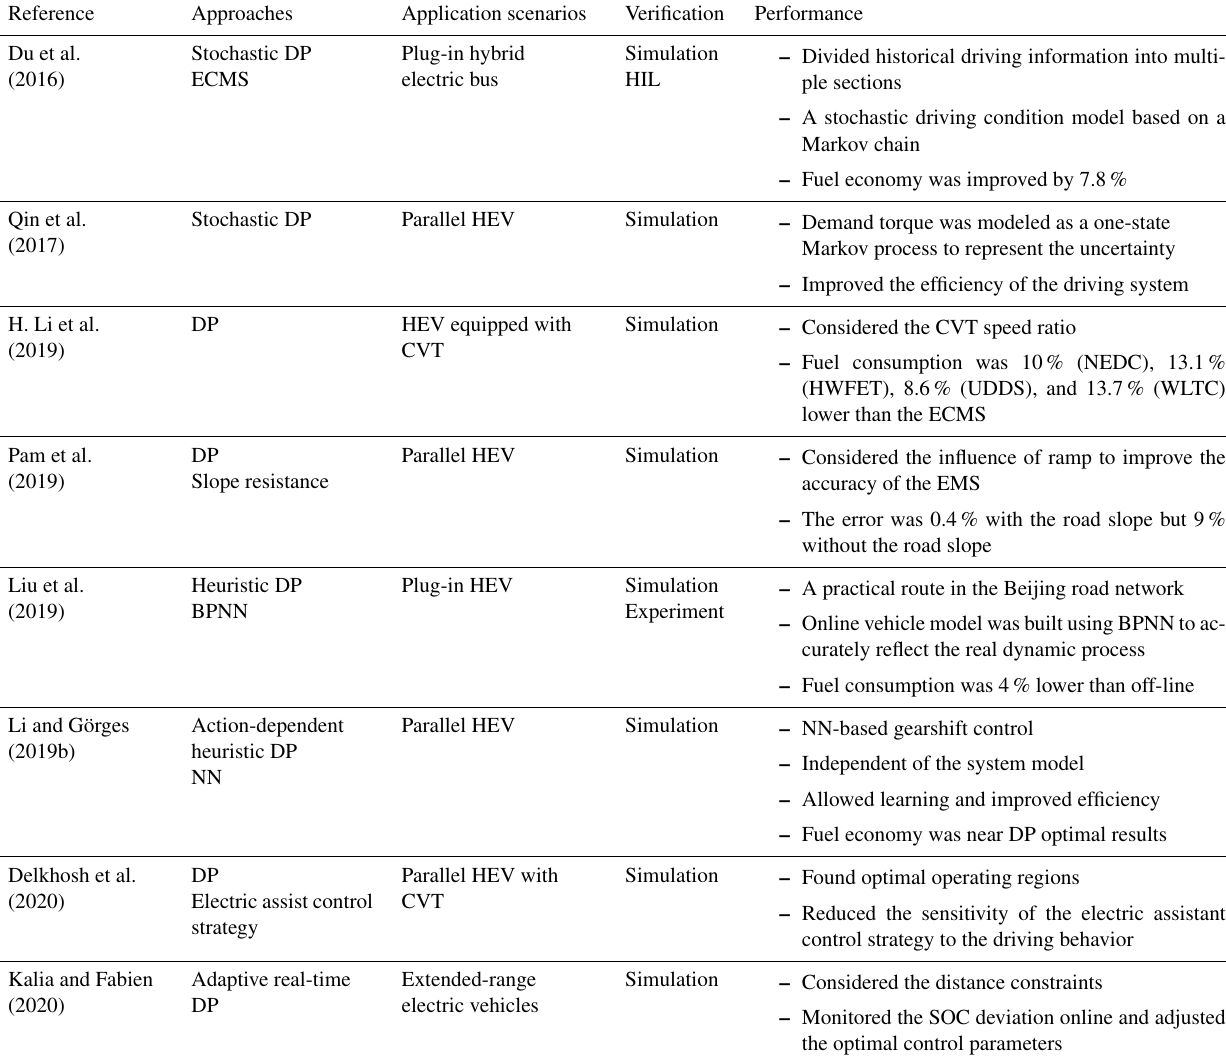
Table 5. Summary of exemplary works on DP-based